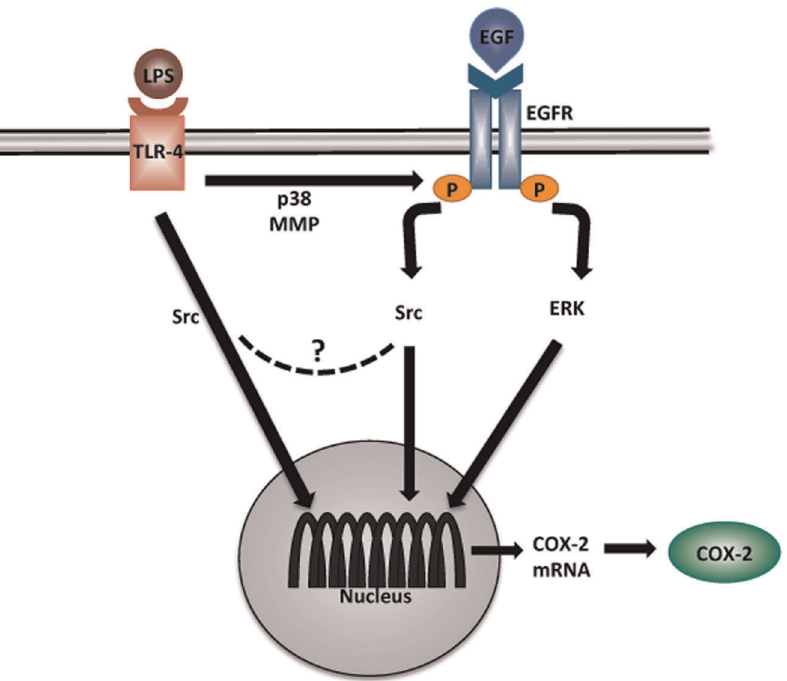
Figure 5. Proposed mechanism of LPS-induced COX-2 stimulation via EGFR transactivation. LPS can induce COX-2 production either directly through TLR-4 signaling or via EGFR transactivation. EGFR transactivation requires p38 and MMP activity. Following EGFR transactivation, COX-2 production can be stimulated either through ERK- or Src-mediated pathways. Although our data suggest that LPS and EGF can induce COX-2 expression through separate pathways, we cannot exclude that the pathway merges downstream prior to transcription.